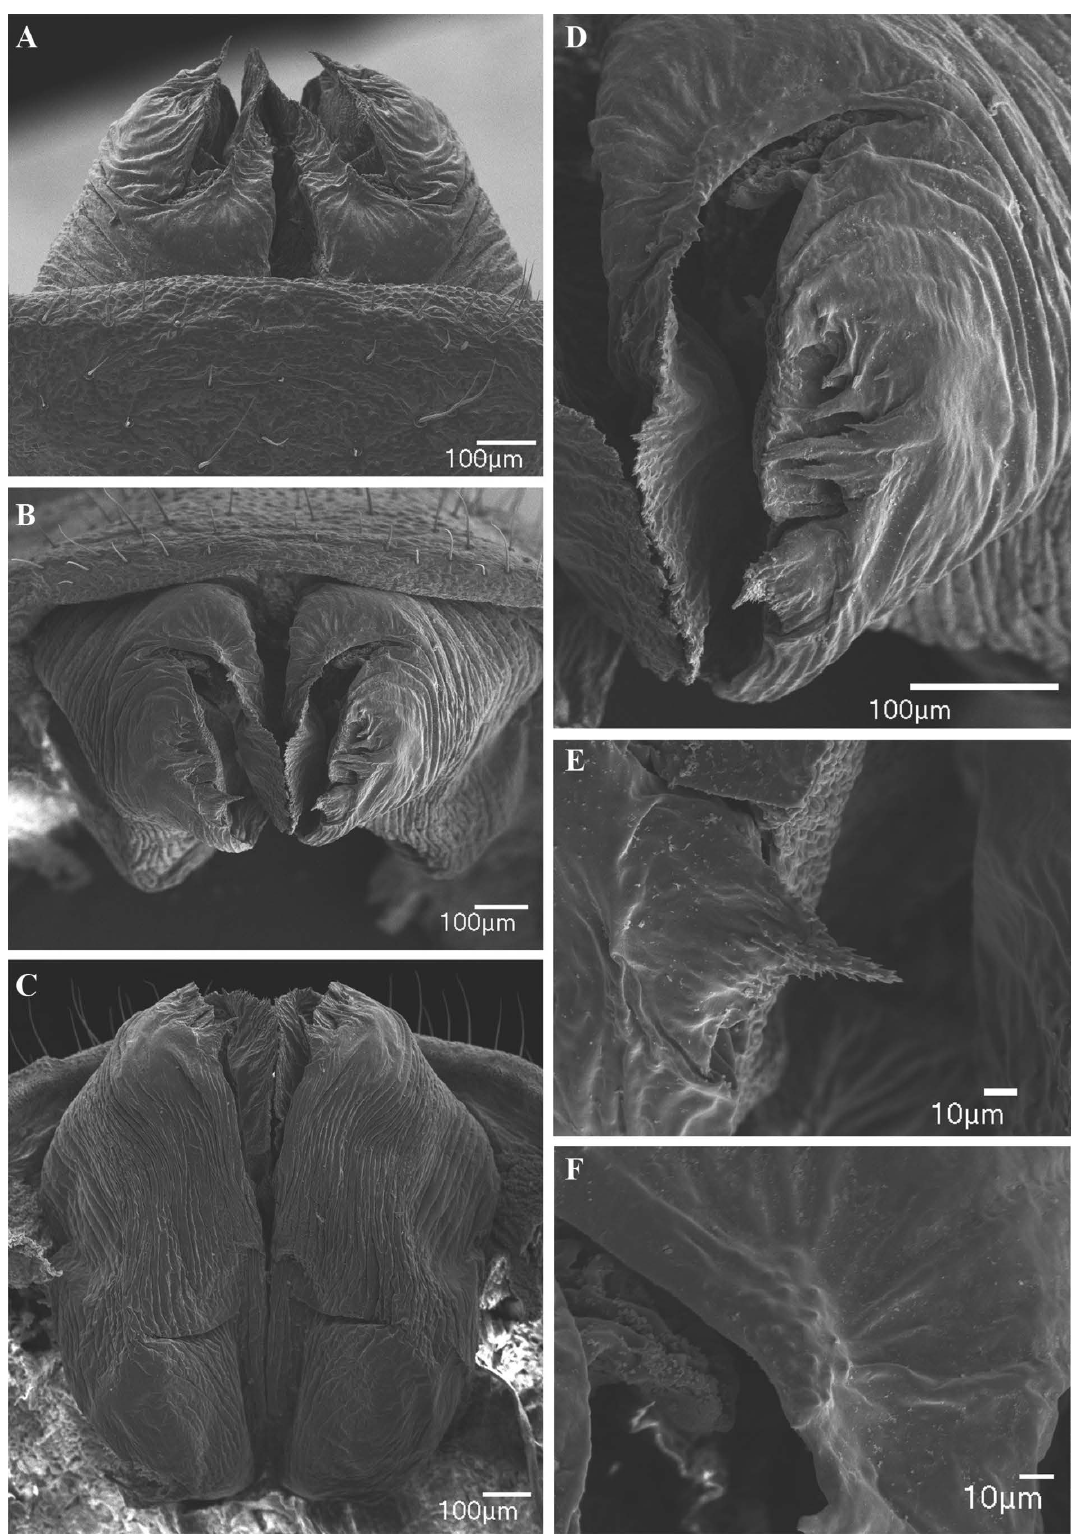
Fig. 50. Charinus carinae sp. nov. (MNRJ 9199), male gonopod. A . Ventral view. B . Posterior view. C . Dorsal view. D . Sinistral side of gonopod. E . Lateral lobe 1. F . Globular projection on dorsal margin of